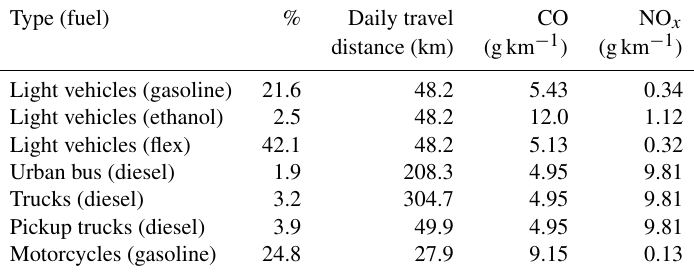
Table 1. Manaus transportation fleet. Percent composition, daily travel distance, and emission factors are listed for different vehicle types in 2014 (ANP,